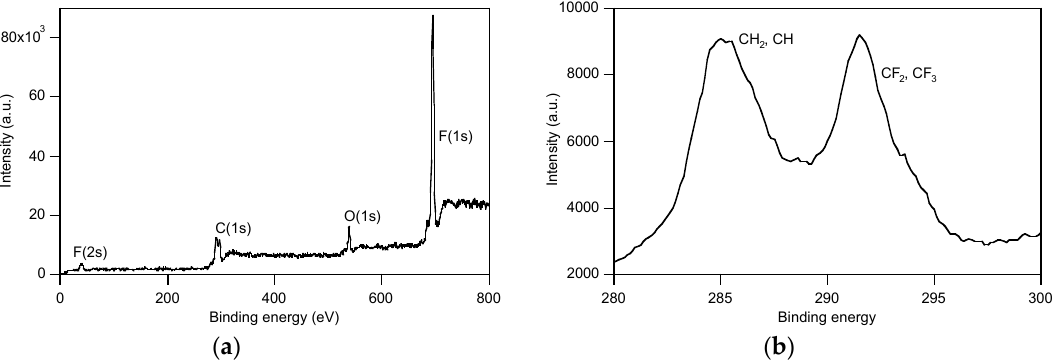
Figure 7. XPS survey ( a ) and high-resolution ( b ) spectra for p(F6 -co- PTMSi5) ( ϕ = 70°) after immersion in water for 24 h.